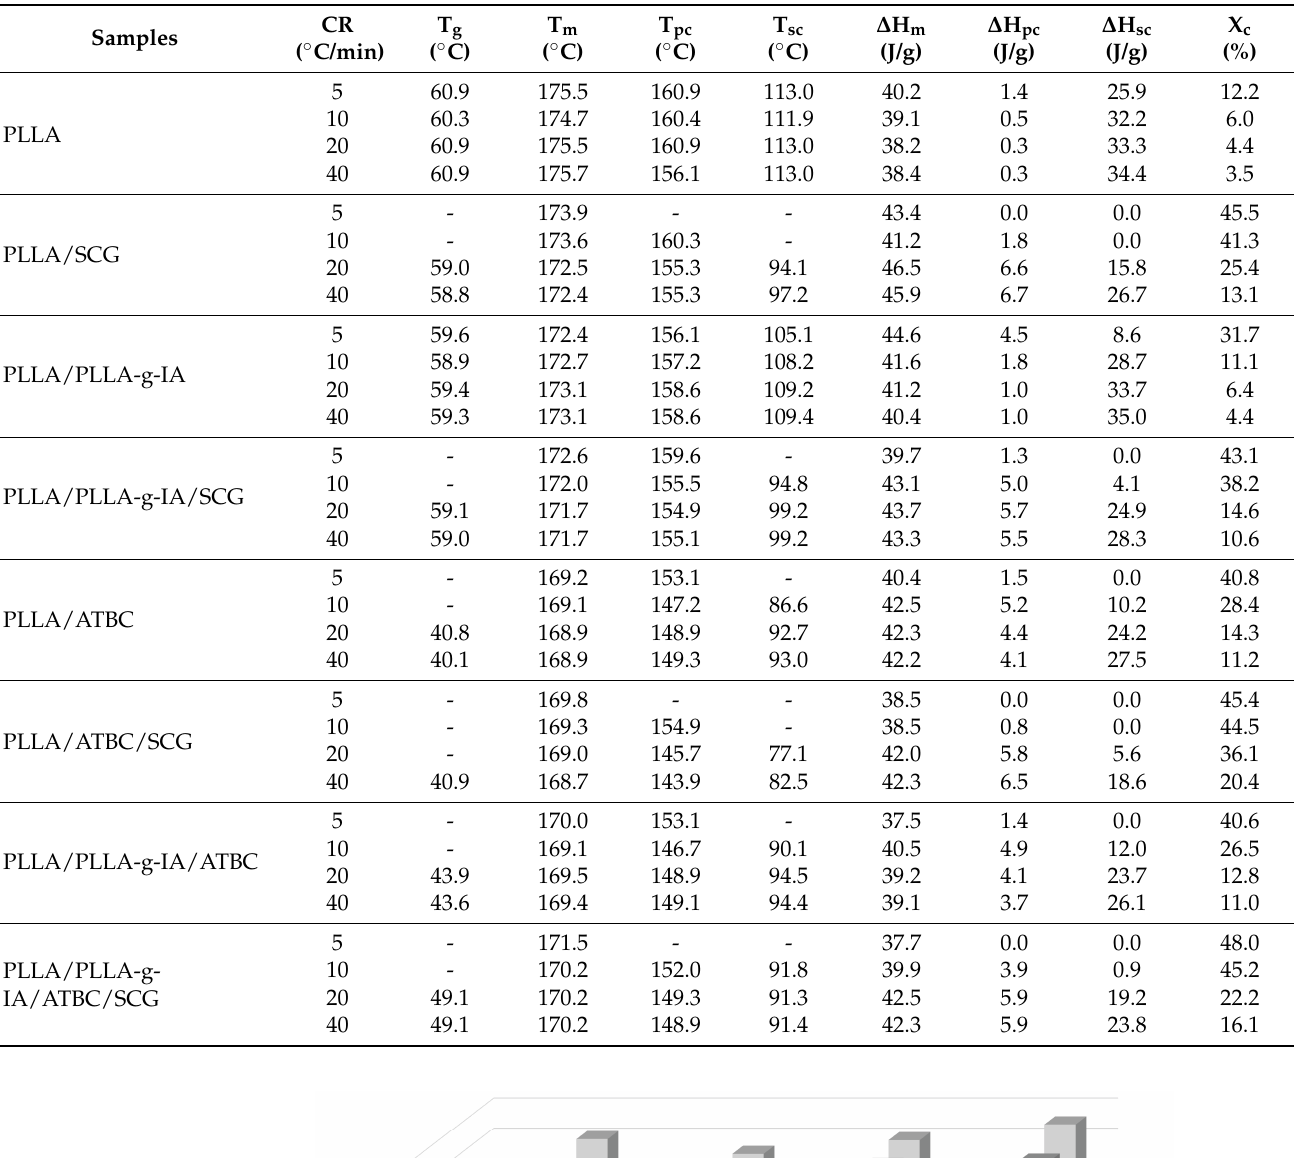
Table 3. The results from the second heating run of DSC analysis.